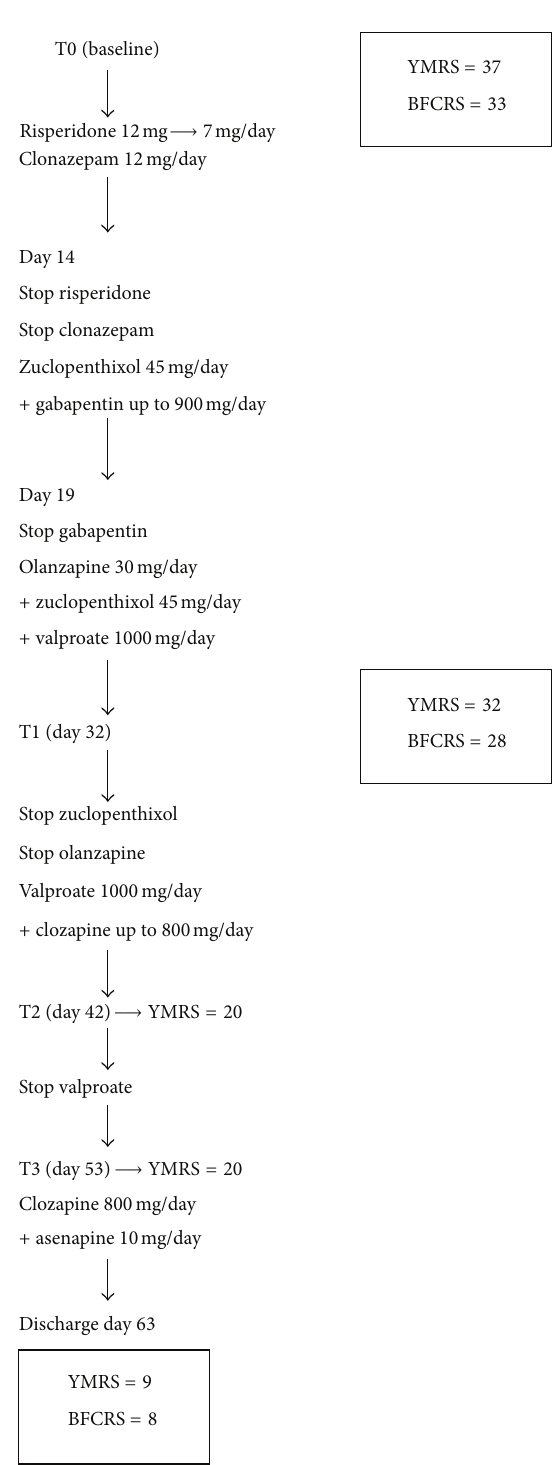
Figure 1: Treatment flow chart with related YMRS and BFCRS total